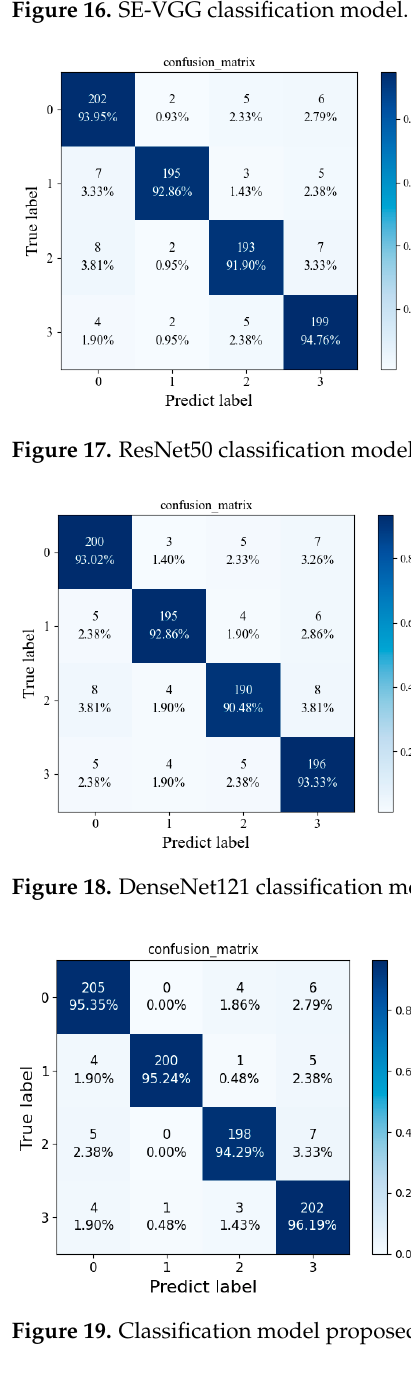
Figure 16. SE-VGG classification model.